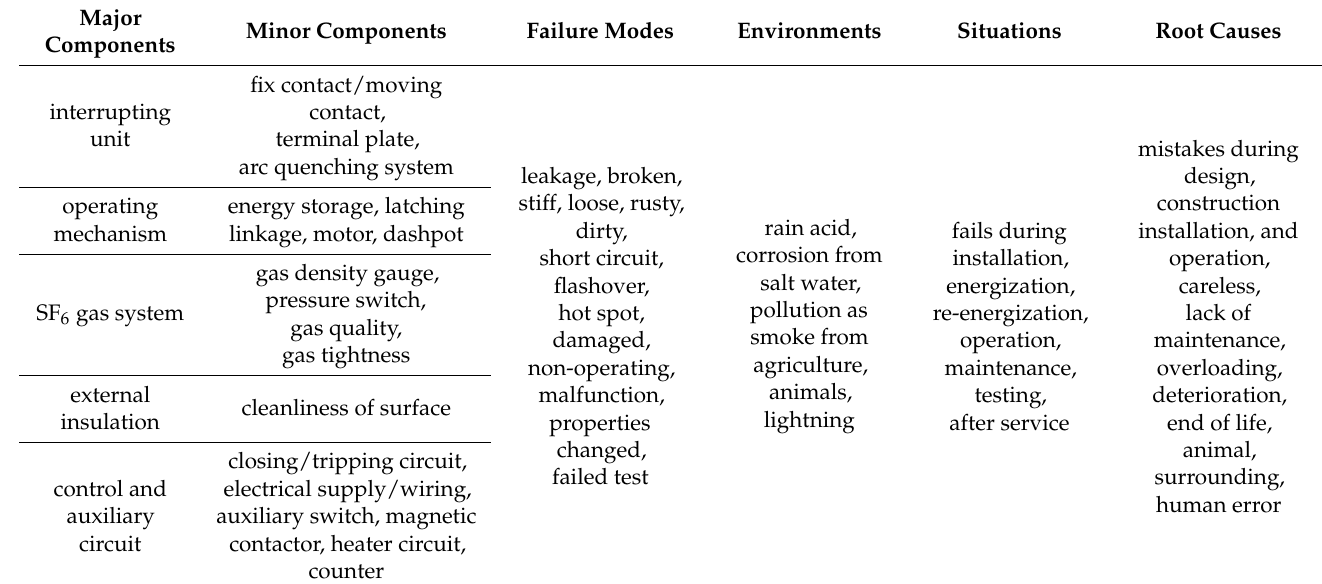
Table 1. Power circuit breaker failure detail.